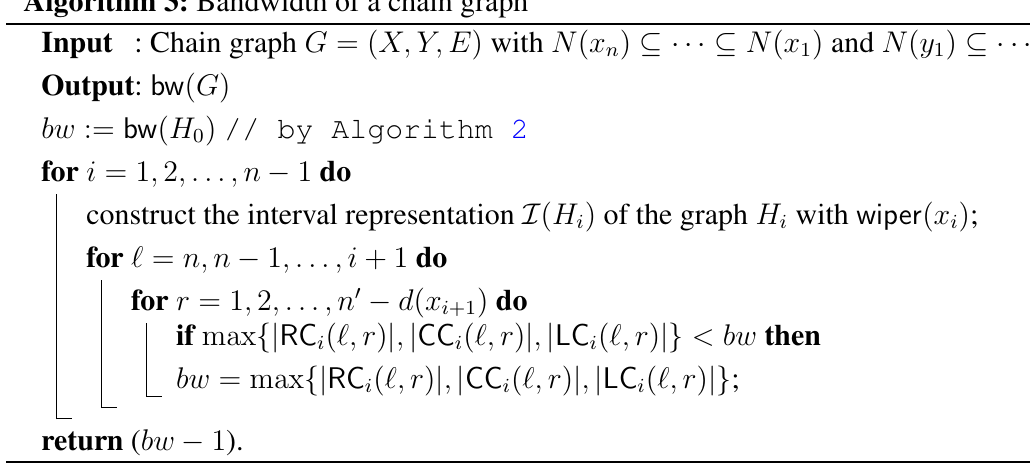
Algorithm 3: Bandwidth of a chain